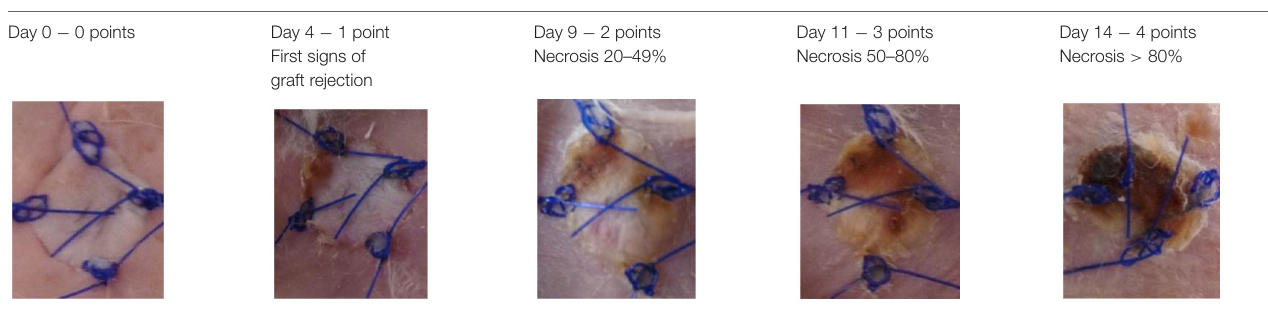
TABLE 1 | Percentage scale to characterize mouse skin graft